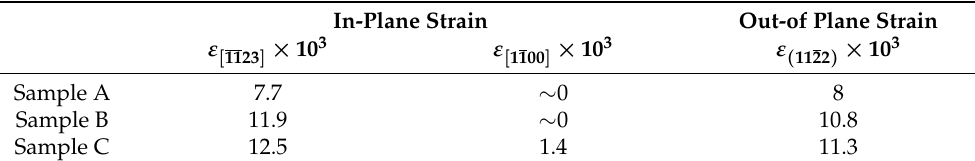
Table 3. Calculated strain in the semipolar (1122) superlattice templates.